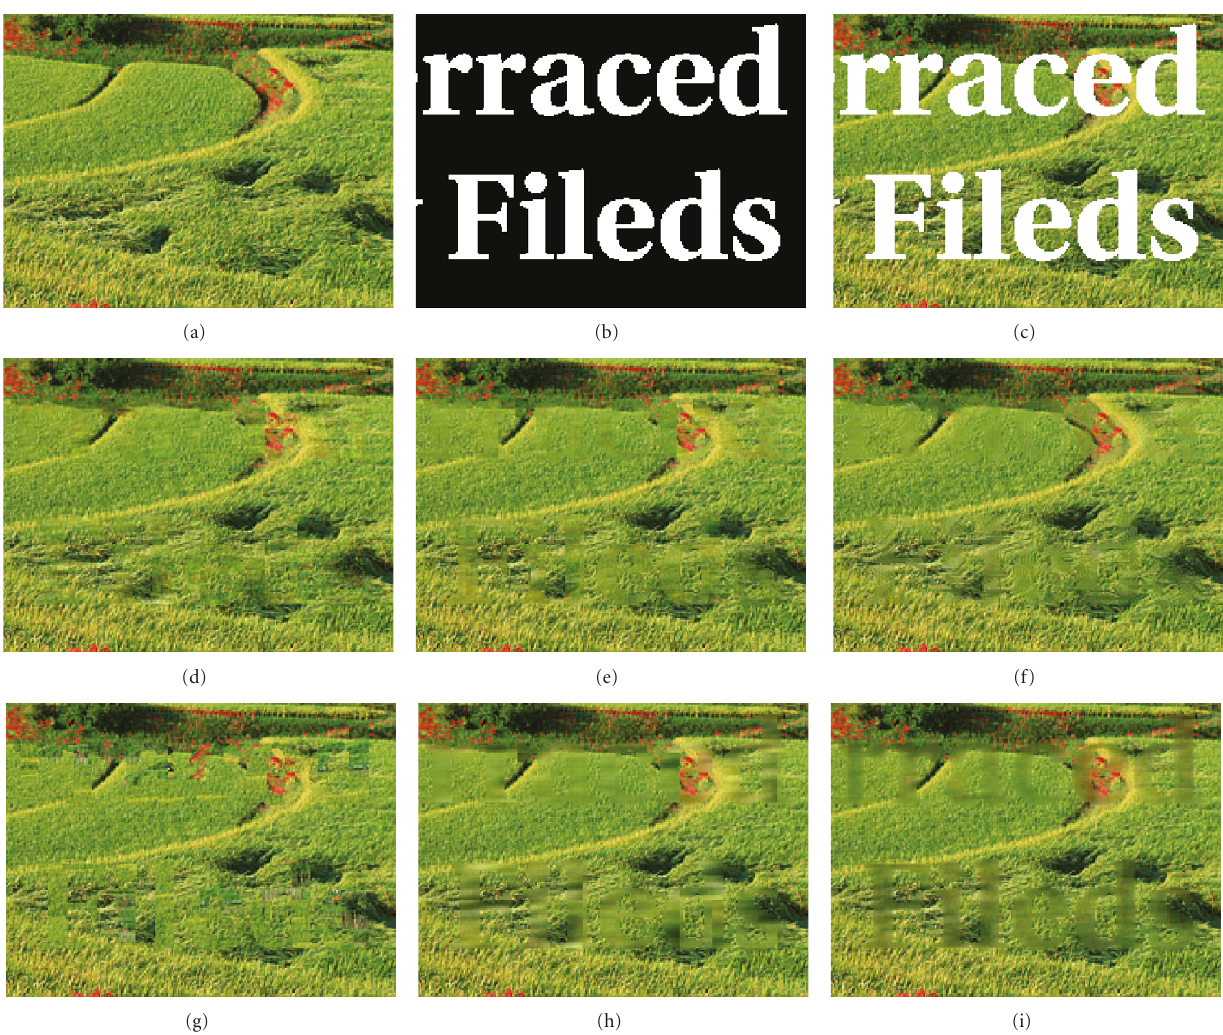
Figure 7: (a) Zoomed portion of Figure 6(a). (b) Zoomed portion of Figure 6(b). (c) Zoomed portion of Figure 6(c). (d) Zoomed portion of Figure 6(d). (e) Zoomed portion of Figure 6(e). (f) Zoomed portion of Figure 6(f). (g) Zoomed portion of Figure 6(g). (h) Zoomed portion of Figure 6(h). (i) Zoomed portion of Figure